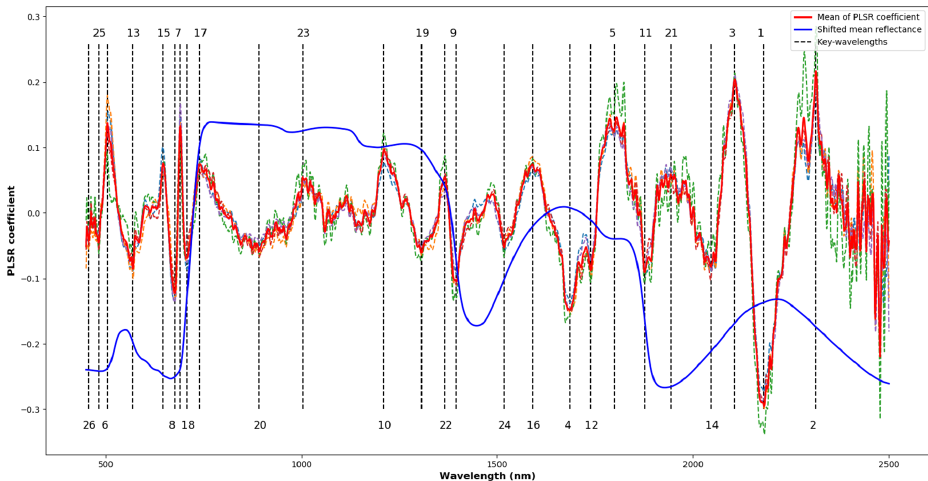
Figure 4. The PLSR coefficients and the key ‐ wavelengths identified. The dotted curves in random colours are the values of the PLSR coefficients in the different folds of validation. The red curve is the average values of the PLSR coefficients in cross ‐ validation and the dotted lines with numbers mark the locations and order of contribution of the key ‐ wavelengths. The vertically shifted average reflectance is plotted in blue. Table 2. Physiological, biochemical and nutritional traits reported previously related to the key ‐ wavelengths identified in this study.